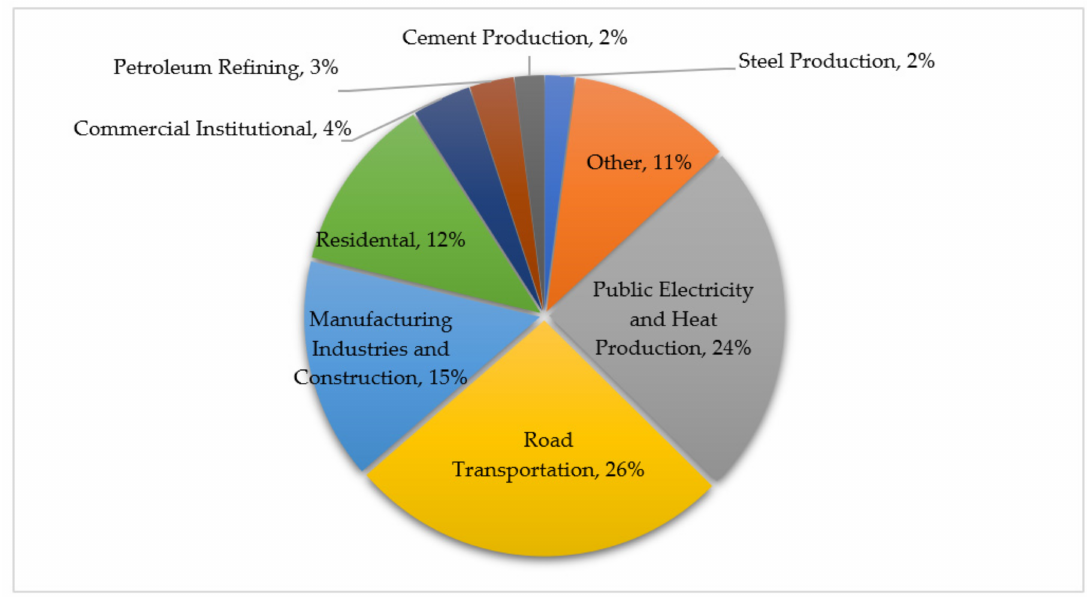
Figure 5. European CO 2 emissions from individual sectors of the economy in 2020